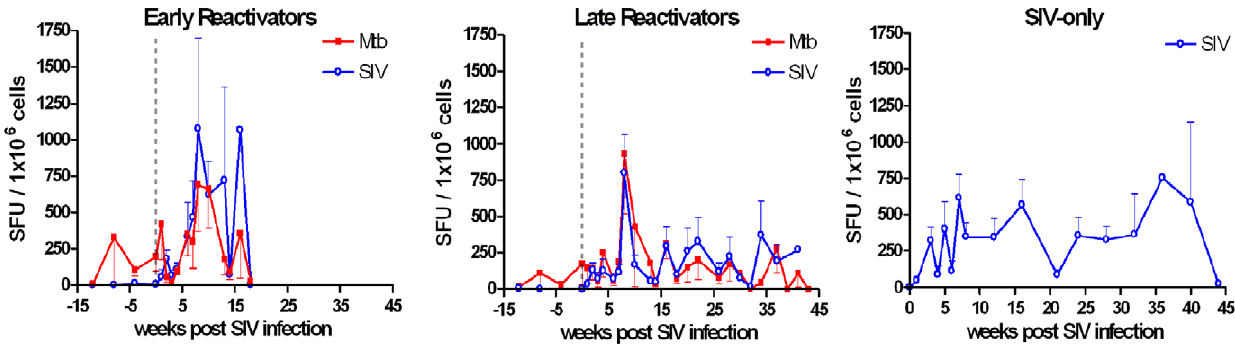
Figure 3. Co-infected monkeys experience an increase in numbers of Mtb-specific T cells following early after SIV infection. IFN c ELISPOTs were performed on PBMCs stimulated with Mtb or SIV antigens. IFN- c was measured in spot forming units (SFU) per 1 6 10 6 cells.